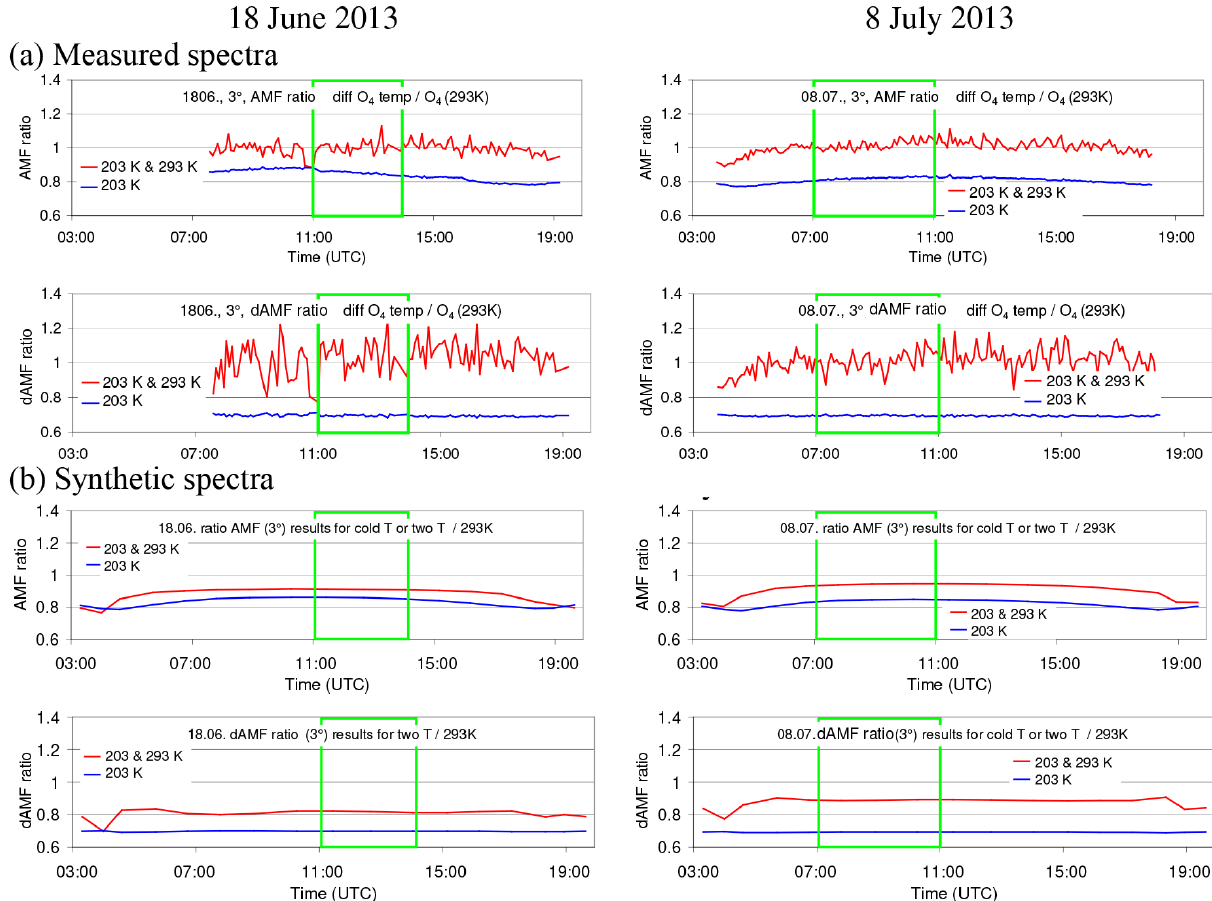
Figure A26. Ratios of the O 4 (d)AMFs derived for O 4 cross sections at different temperatures (either 203K or both 203 and 293K) vs. those for the standard analysis (using the O 4 cross section for 293K) for both selected days ( a : results for spectra measured by the MPIC instrument; b : results for synthetic spectra when taking into account the temperature dependence of the O 4 cross